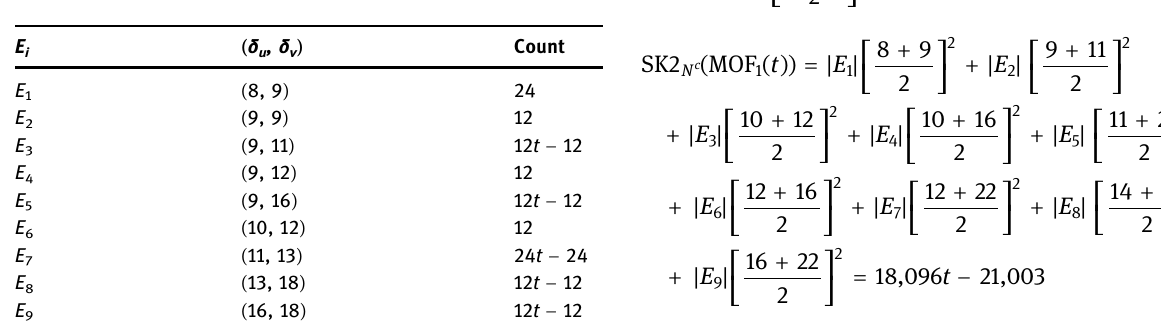
Table 4: Closed neighbourhood degree sum - based edge partitions of MOF 2 ( t